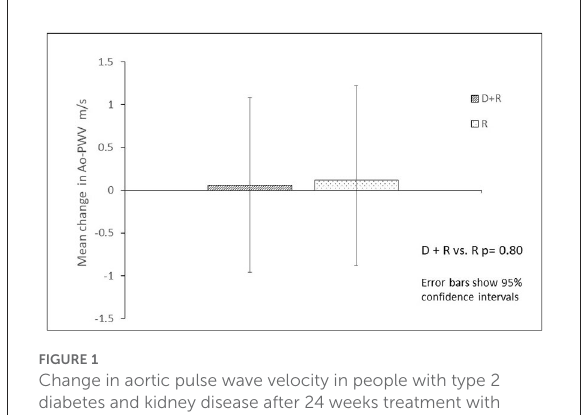
FIGURE1 Change in aortic pulse wave velocity in people with type 2 diabetes and kidney disease after 24 weeks treatment with Ramipril only vs. Dapaglifozin +